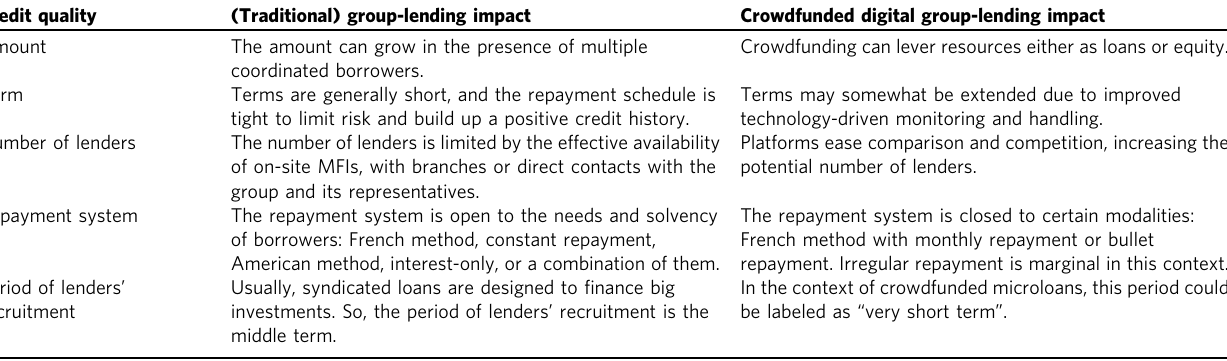
Table 1 Impact of traditional and crowdfunded group lending on credit quality. Source: Own